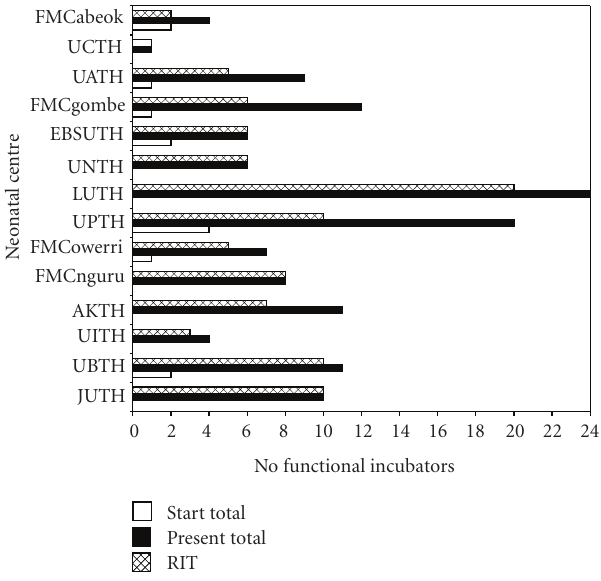
Figure 5: Total number of functional incubators at various centres. The three descriptive bars for each centre represent the number of functional incubators in each centre before RIT (total at start), the total number of current functional incubators (total presently), and finally, the number of those current func- tional incubators that are RIT; abbreviated centres are: University Teaching Hospitals at Jos (JUTH), Benin-City (UBTH), Ilorin (UITH), Kano (AKTH), Port Harcourt (UPTH), Lagos (LUTH), Enugu (UNTH), Abakaliki (EBSUTH), Abuja (UATH), Calabar (UCTH) and Federal Medical Centres at Owerri (FMCowerri), Nguru (FMCnguru), Abeokuta (FMCabeok), Gombe (FMC-